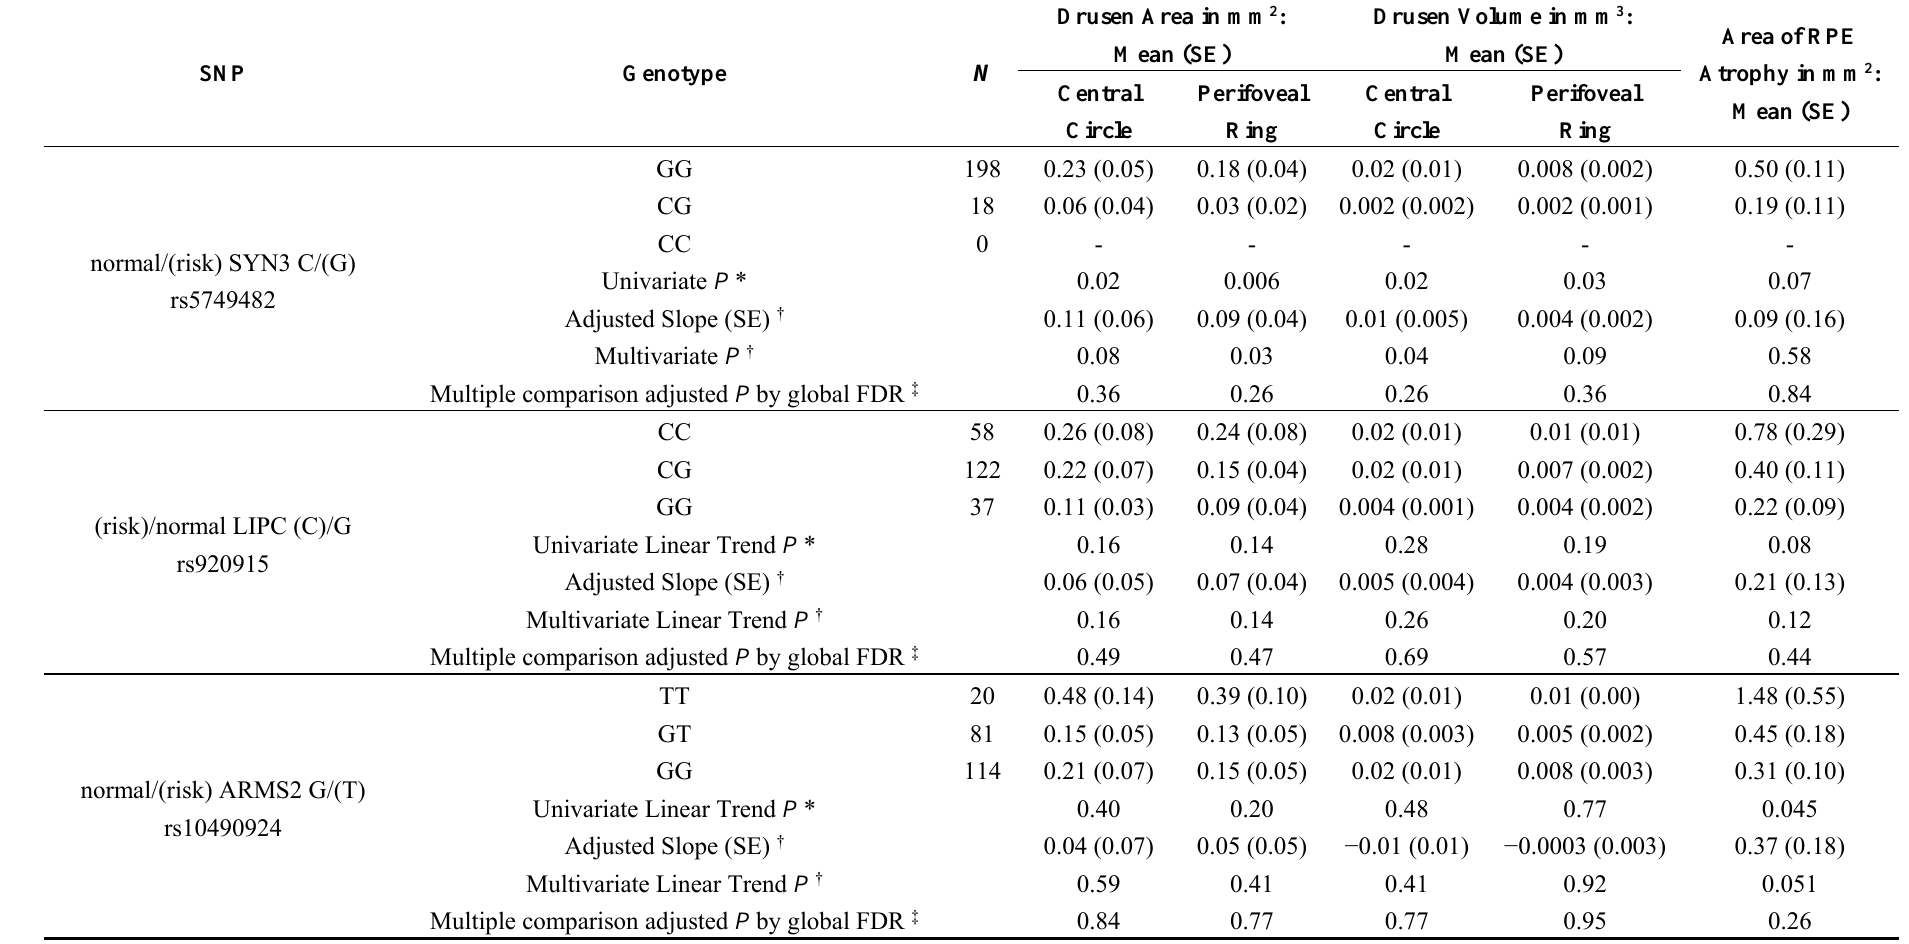
Table 2. Genotypic associations with optical coherence tomography (OCT) drusen area, drusen volume and area of retinal pigment epithelium (RPE) atrophy from univariate analysis and multivariate analysis § (216 subjects, 432 eyes). SNP Genotype